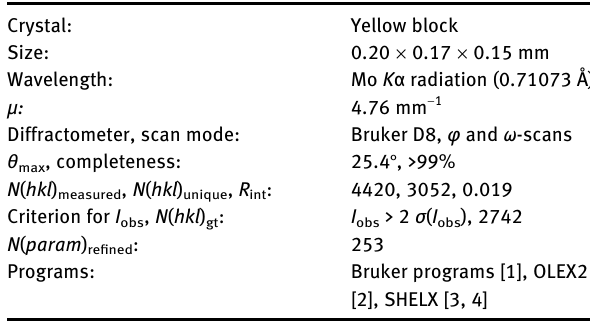
Table 1 contains crystallographic data and Table 2 contains the list of the atoms including atomic coordinates and displacement parameters.